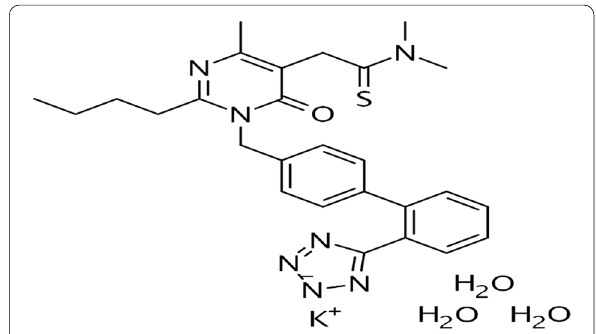
Fig. 1 Chemical Structure of Fimasartan Potassium Trihydrate [2]